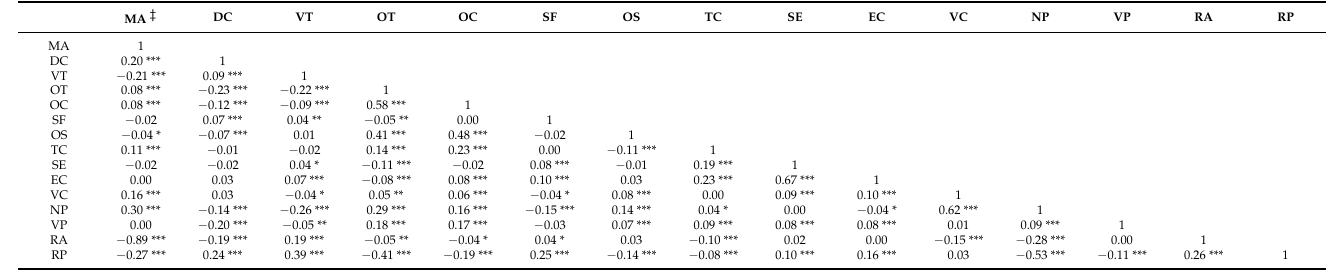
Table 6. Pearson correlation coefficients for continuous explanatory variables describing the level of territorial cohesion